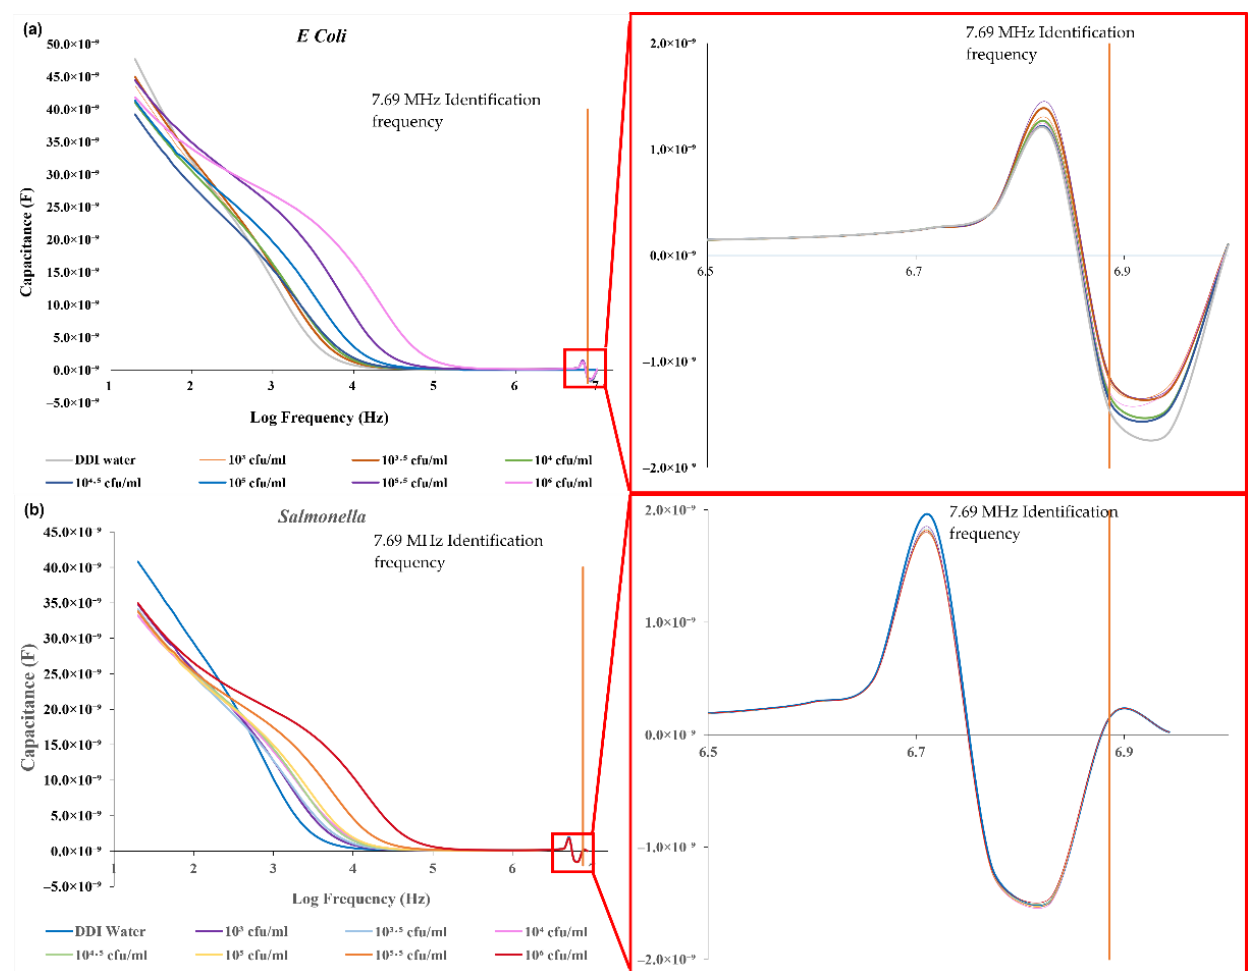
Figure 5. Capacitance spectrum of ( a ) E. coli and ( b ) Salmonella samples.